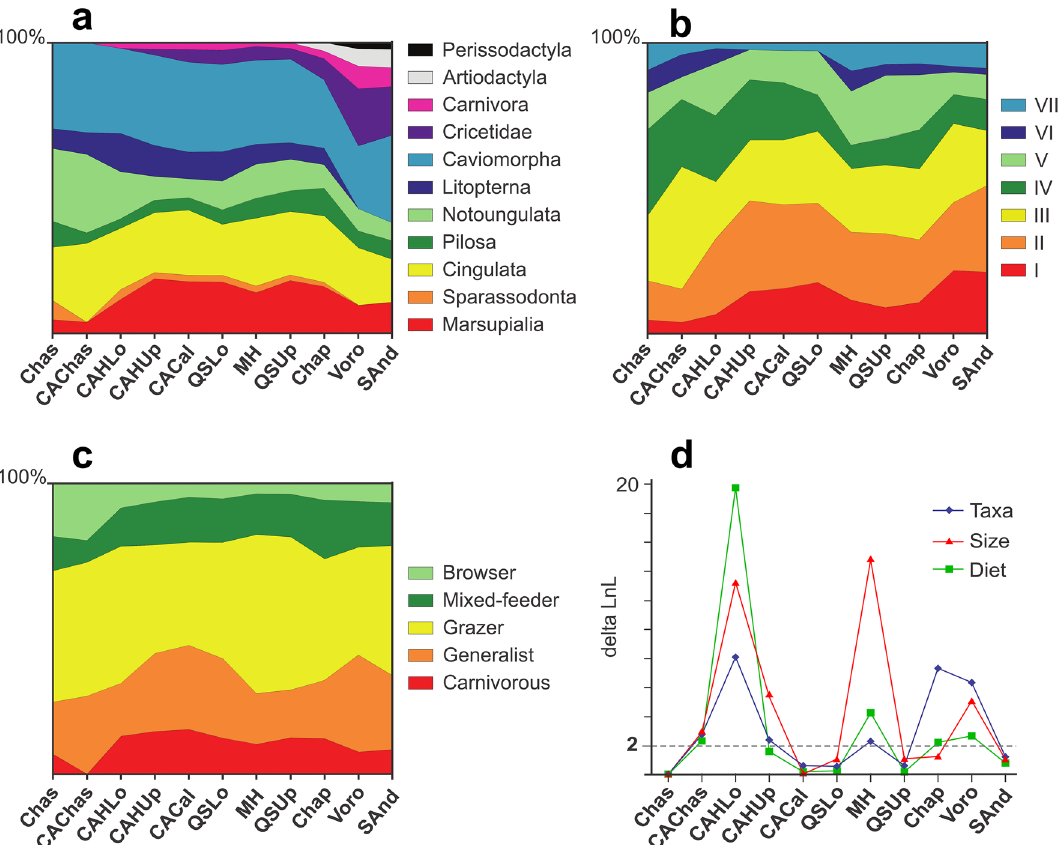
Figure 4. Change in structural parameters of investigated faunas through time (approach 2). ( a ) Proportion of taxonomic groups across the Neogene faunas; ( b ) changes in proportion of body size classes (I, less than 100 g; II, between 100 g and 1 kg; III, 1–10 kg; IV, 10–100 kg; V, 100–500 kg; VI, 500–1000 kg; and VII, more than 1000 kg); ( c ) proportion of dietary classes across the Neogene faunas; ( d ) Log-Likelihood difference between successive faunas (significant cutoff [2] is indicated with a dashed line). Abbreviations in Table